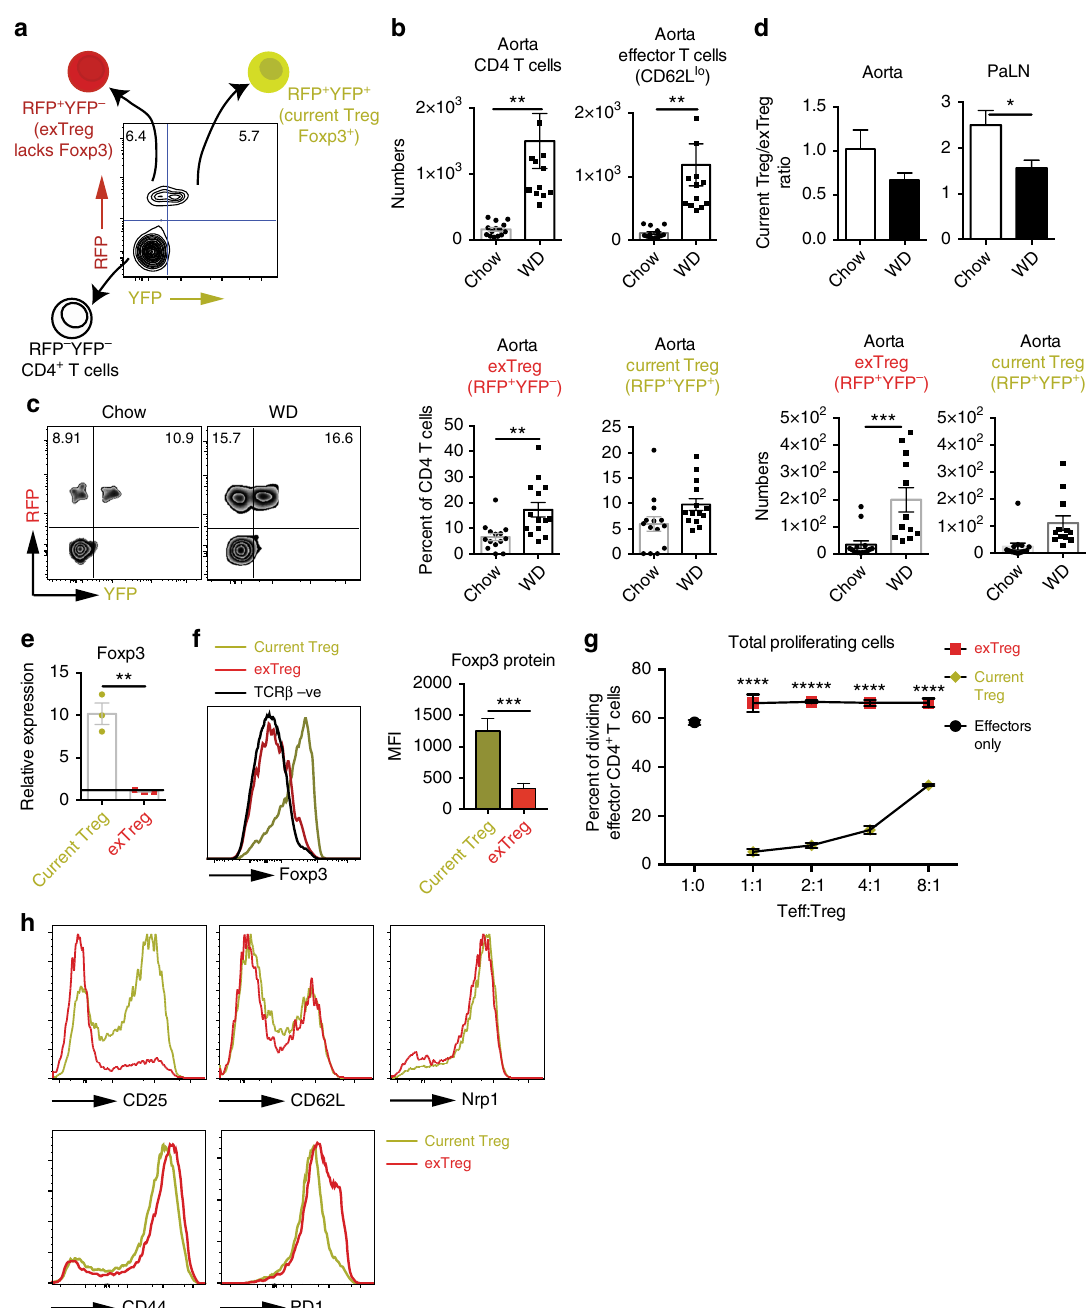
Fig. 1 ExTreg cells are increased during atherogenesis. a Schematic diagram with a representative fl ow cytometry plot of the Treg lineage tracker-ApoE − / − (LT-ApoE − / − ) mouse model used to track Treg development during atherosclerosis. The diagram shows two population of Treg; current Treg (RFP + YFP + ) cells, which express Foxp3, and exTreg (RFP + YFP − ) cells, which previously expressed Foxp3. b – d LT-ApoE − / − mice were fed a western diet for 15 weeks. Bar graphs compare the numbers of total CD4 T cells and effector CD62L lo cells ( b ), the percentages and numbers of exTreg and current Treg ( c ) in the aorta, and the ratio of current Treg to exTreg in the aorta and PaLN ( d ) of western fed-diet to chow controls. c Representative fl ow cytometry plots and graphs showing the percentages of exTreg and current Treg in the aorta of the above mice. ( e ) Current and exTreg cells were sorted from the PaLN of LT- ApoE − / − mice and mRNA levels for Foxp3 were examined in the extracted RNA and normalized to β -actin . f Foxp3 protein expression levels in current Treg, exTreg cells and TCR β negative cells. Representative fl ow cytometry histograms and bar graphs show the MFI of Foxp3 in the two cell populations. g Treg suppression assay using sorted current and exTreg from spleens and peripheral LNs from LT-ApoE − / − mice. Sorted current and exTreg cells were cultured with CD4 depleted feeder cells from spleens of B6 mice and increasing numbers of naive effector CD45.1 CD4 T cells (CD25 − CD44 lo CD62L hi ) that were labeled with Cell Trace Violet (CTV). Cells were stimulated with soluble α CD3 for 4 days, harvested and effector cells (CD4 + CD45.1 + ) were examined for the dilution of CTV by fl ow cytometry. h Flow cytometry histograms showing expression pattern of CD25 (IL-2R α ), CD62L, Nrp1, CD44 and PD1 on current Treg and exTreg cells. Results are expressed as mean ± s.e.m. from two independent experiments ( n = 14) ( b – d ), a representative of two independent experiments ( n = 3) ( e , g ), and a representative of two independent experiments ( n = 11) ( f ). Statistical signi fi cant differences were at * P < 0.05, ** P < 0.01, *** P < 0.001, and **** P < 0.0001 (unpaired Student ’ s t